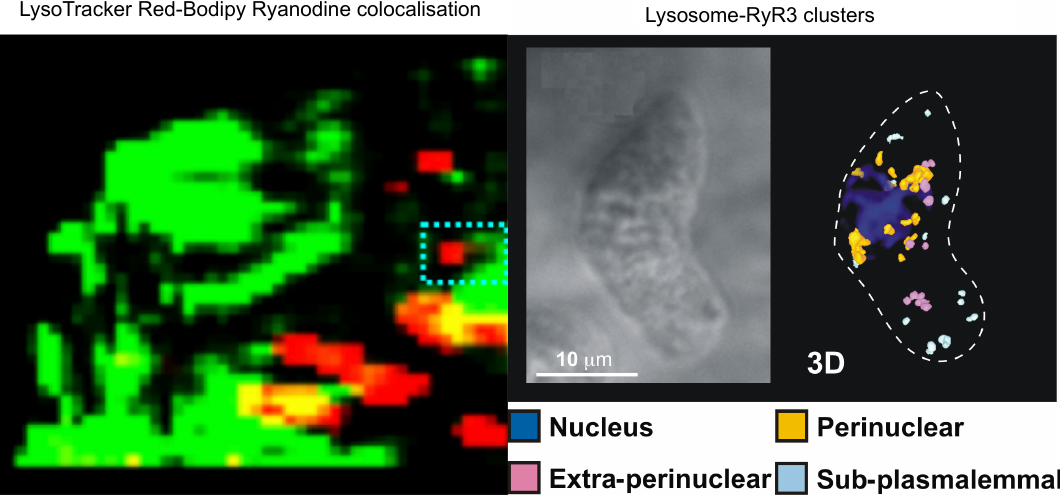
Figure 9. Example images showing lysosome-SR nanojunctions. Left hand image shows enlarged segment of an acutely isolated pulmonary arterial myocyte, that identifies nanojunctions (yellow) between LysoTracker Red labelled acidic stores and Bodipy-ryanodine positive SR in an acutely isolated pulmonary arterial myocyte. Dashed blue rectangle (vertical axis, 0.5 µ m) identifies a Lysotraker Red labelled organelle and Bodipy-ryanodine labelled SR in the same focal plane, but separated by ~0.5 µ m. Right hand panels show a brightfield image ( left ) and a 3D reconstruction ( right ) of a fixed cell labelled for lysosomes ( α IGP120), RyR3 and the nucleus (DAPI, navy blue), that identifies lysosome-RyR3 clusters colour coded by region of the